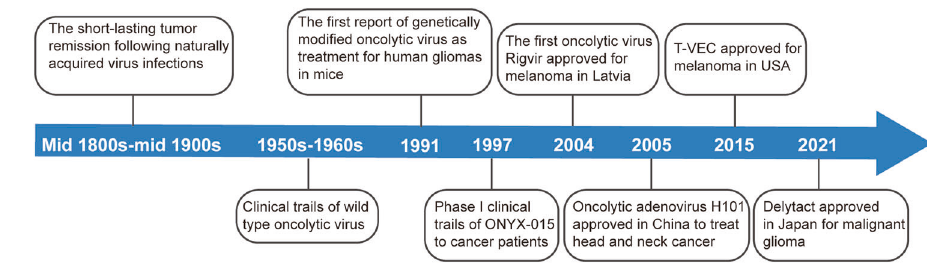
Fig. 1 A timeline of important milestones in the development of oncolytic virus as a cancer